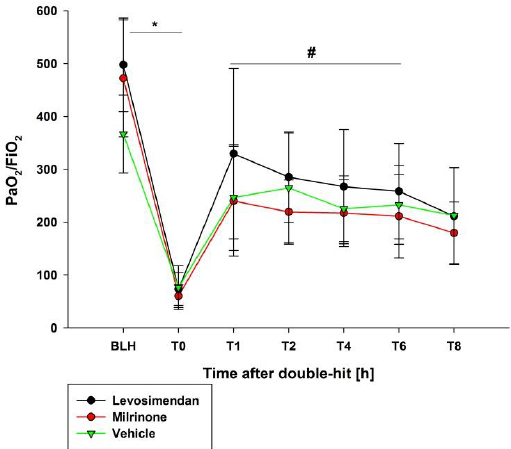
Figure 2. PaO 2 /FiO 2 ratio. * indicates p < 0.05 BLH vs. T0 for all groups. # indicates p < 0.05 levosimendan vs. milrinone T1–T6. h: hours. PaO 2 : partial pressure of oxygen. FiO 2 : fraction of inspired oxygen. BLH: baseline healthy. T x : timepoint. Table 1. Respiratory data over time. Values are mean (SD). * indicates p < 0.05 vs. baseline value. # indicates p < 0.05 in intergroup comparison. SpO 2 : oxygen saturation; AaDO 2 : alveolo–arterial oxygen difference; PaO 2 : arterial oxygen; FiO 2 : fraction of inspired oxygen; PaO 2 /FiO 2 : oxygen index; FRC: fraction of inspired oxygen; MV: minute volume; TV: tidal volume; Ppeak: peak